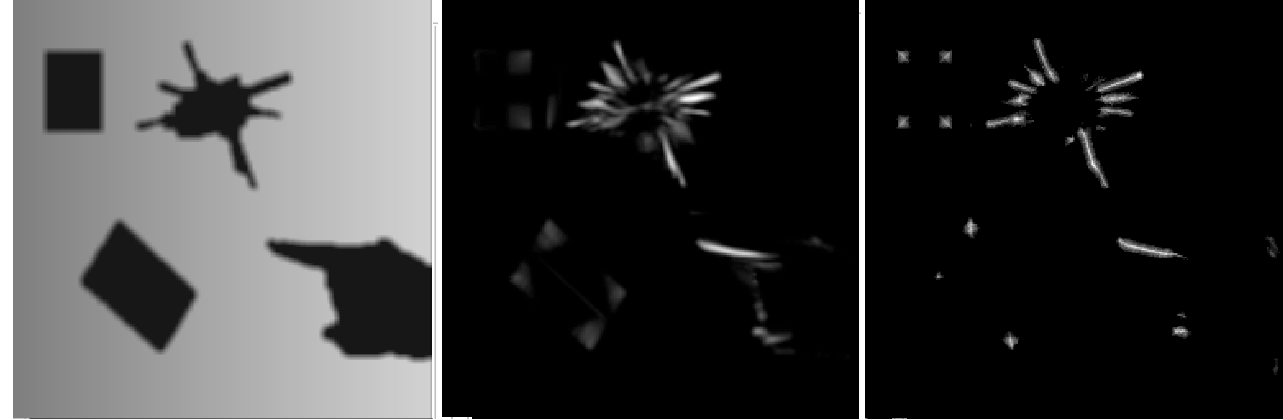
Figure 3 . Bilateral symmetry with the original image on the left, symmetry map produced by Reisfeld’s method using a kernel size of 16 in the middle and the IGHM based method with a Dij of 16.